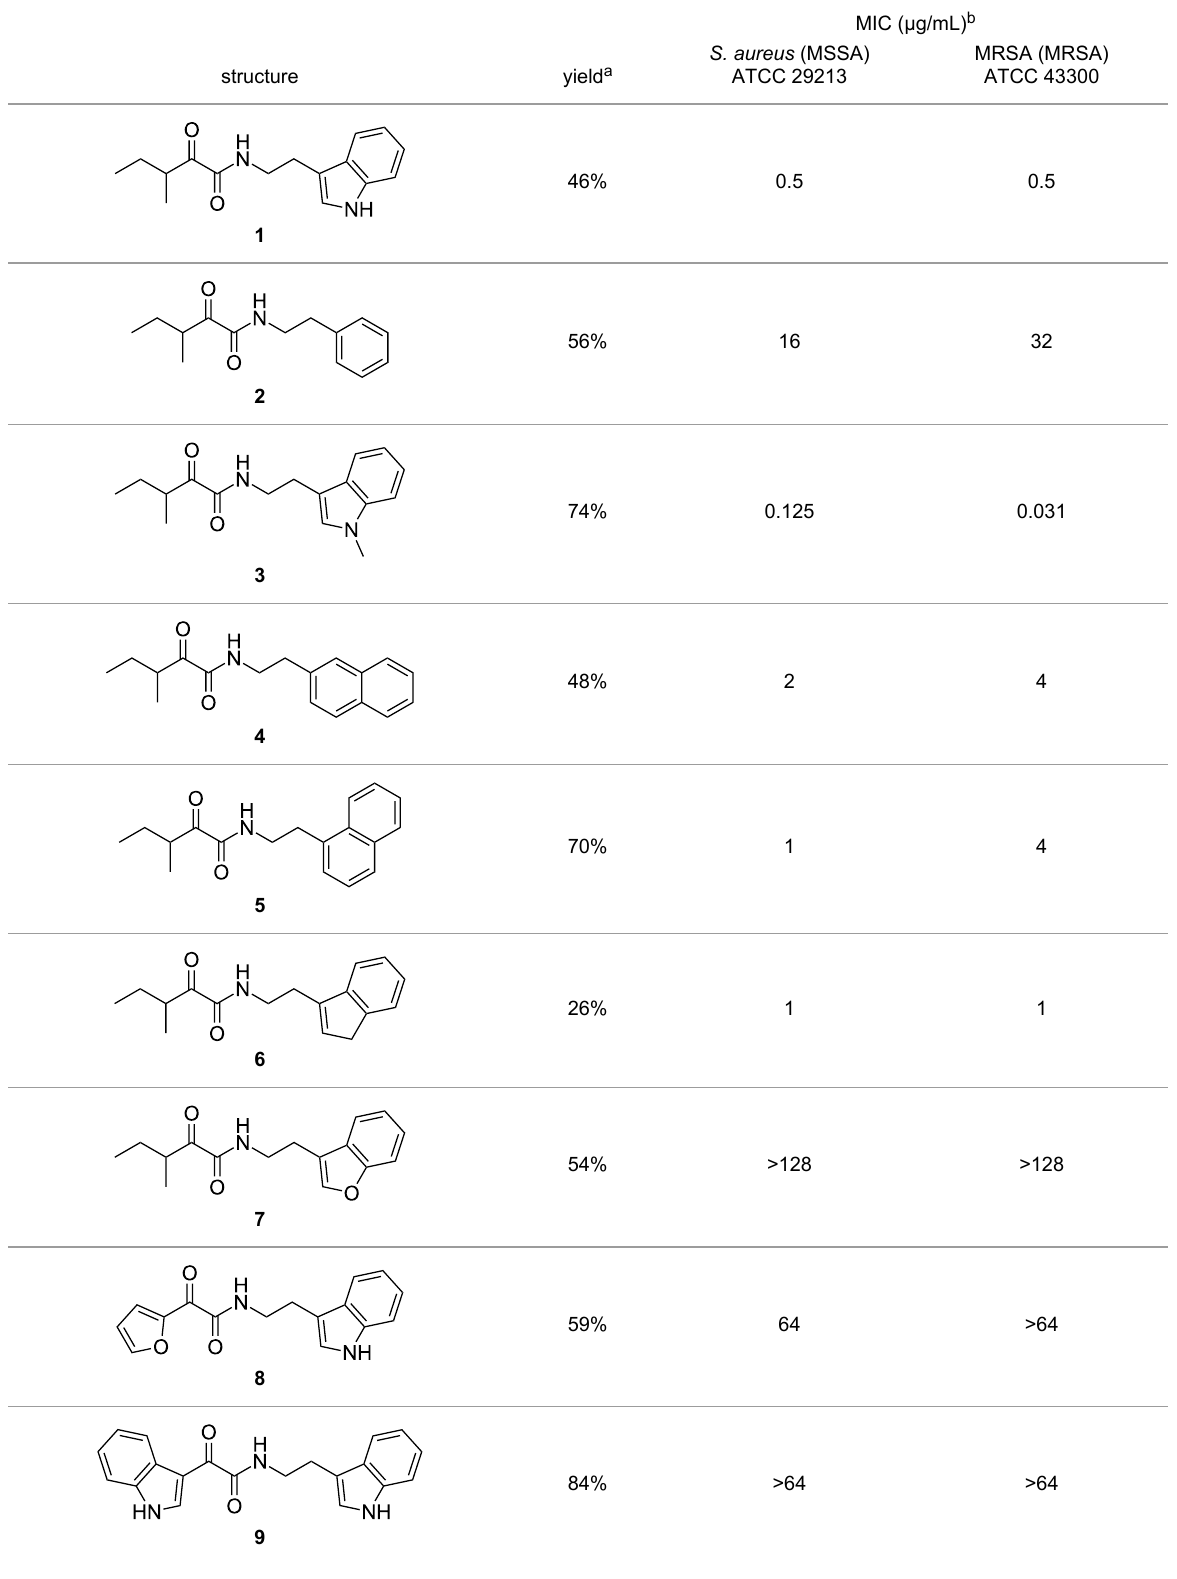
Table 1: Summary of synthesized nematophin derivatives ( 1 – 12 ) and their bioactivity (MIC in µg/mL) against S. aureus (MSSA and